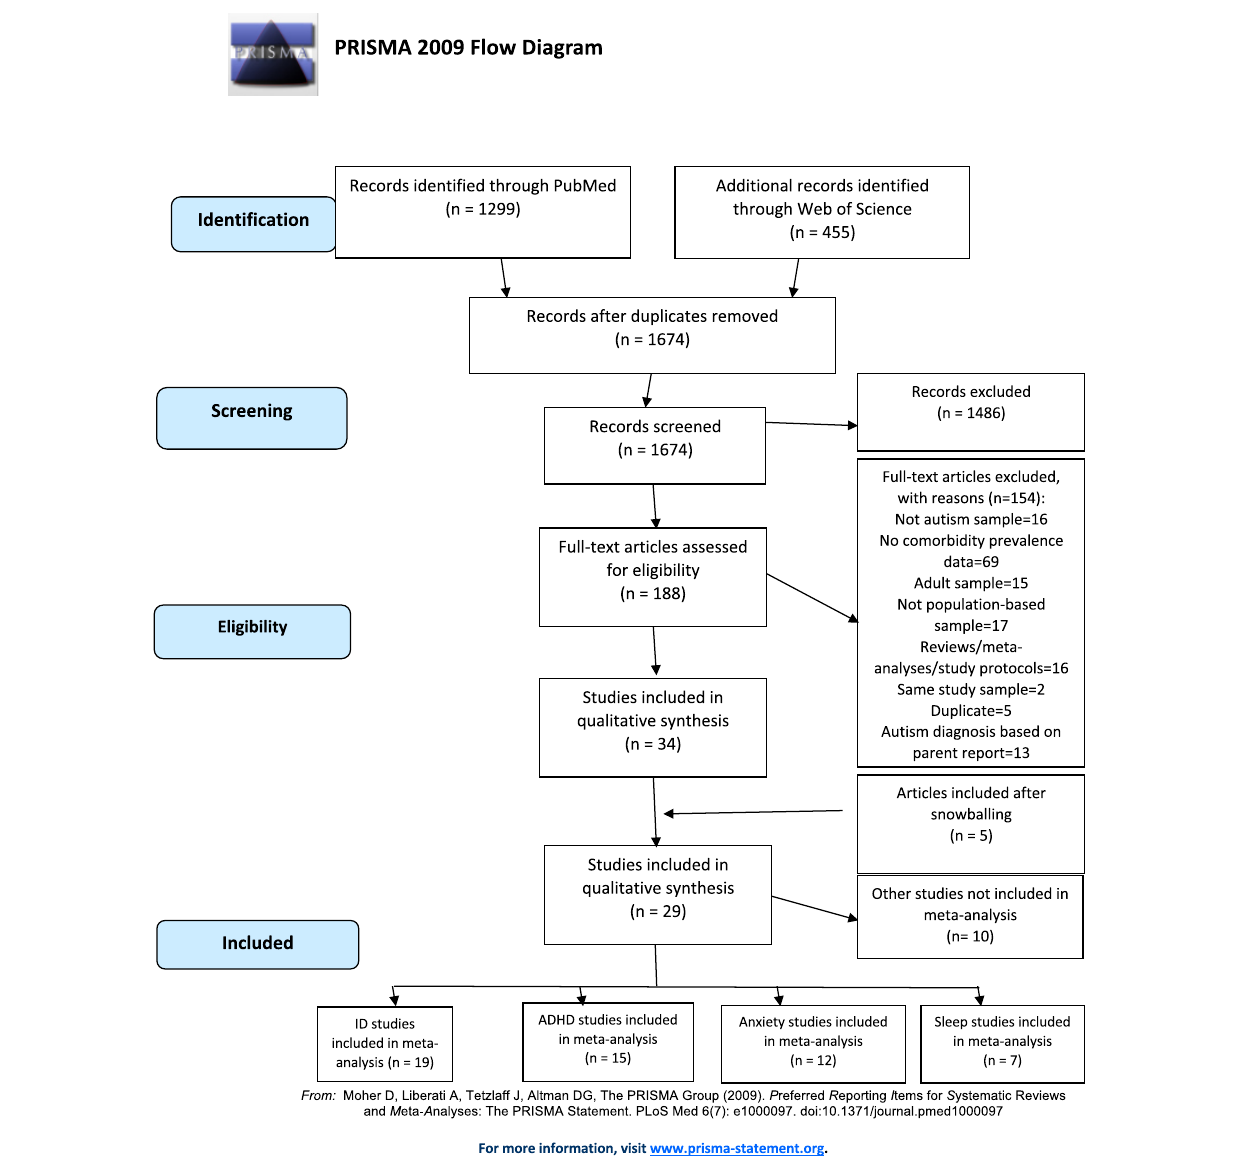
FIGURE 1 | Flow diagram for identification of population-based studies on psychiatric comorbidities in autism spectrum